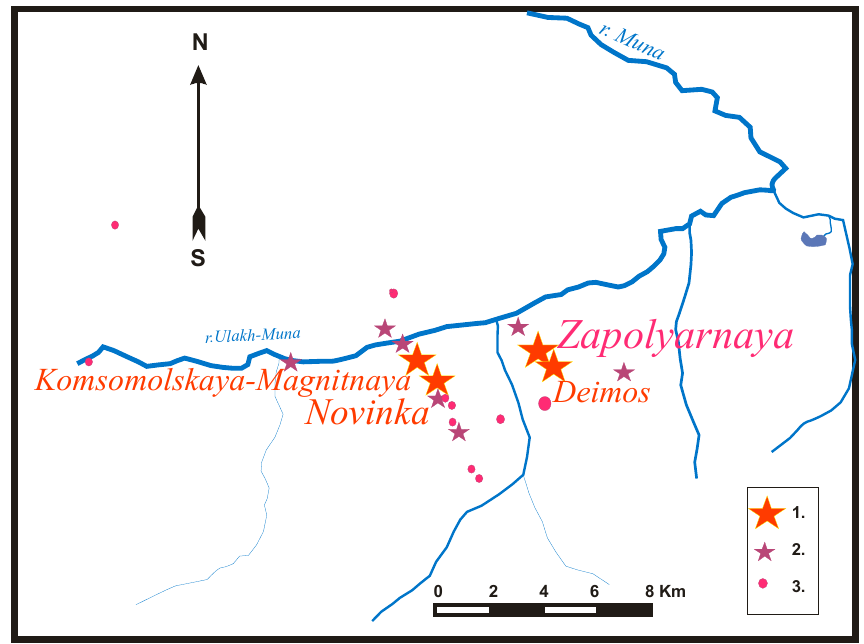
Figure 2. Scheme of the kimberlite pipes’ location in Upper Muna field [5]. 1. Large pipe excavating in quarries. 2. Large pipes without excavations. 3. Small kimberlite pipes.